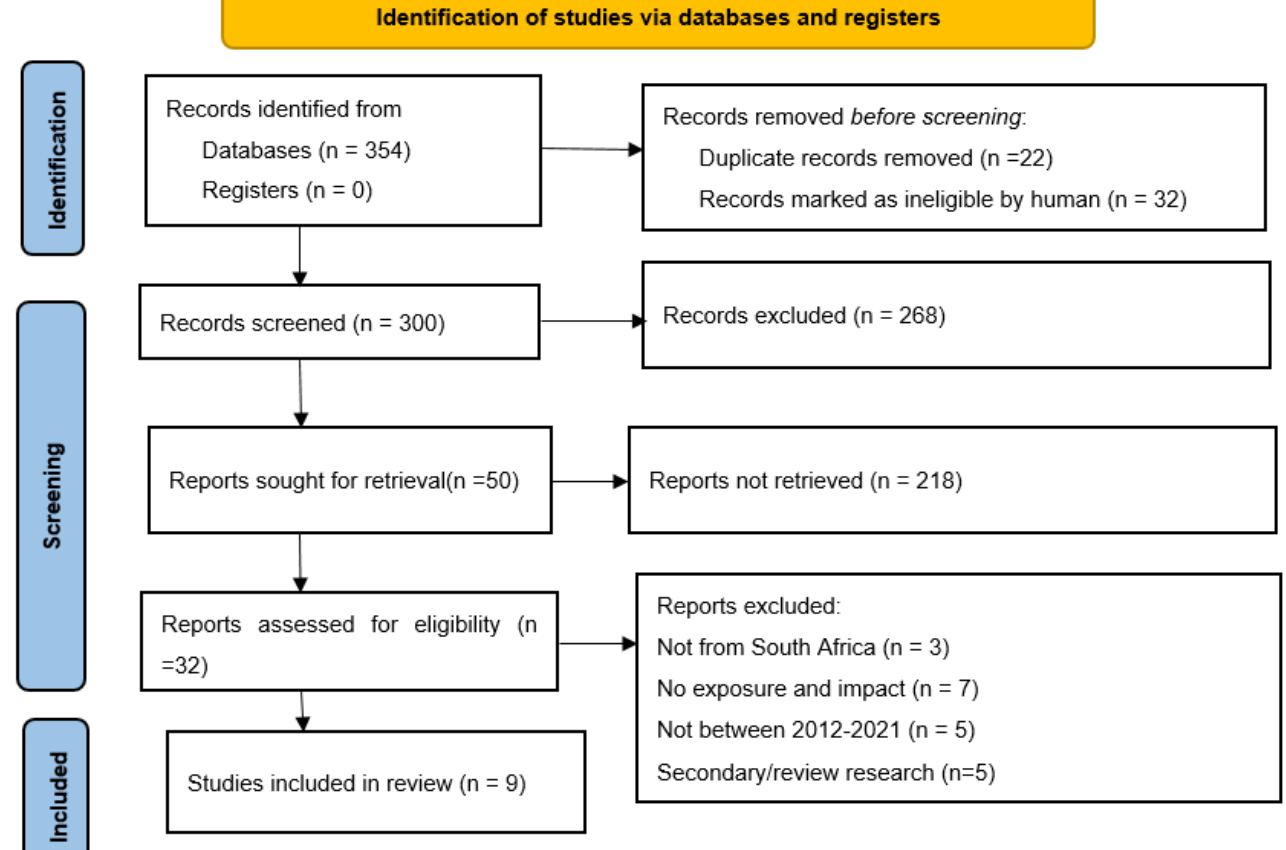
Figure 1. Preferred reporting items for systematic reviews and meta-analyses (PRISMA) flow dia- gram.